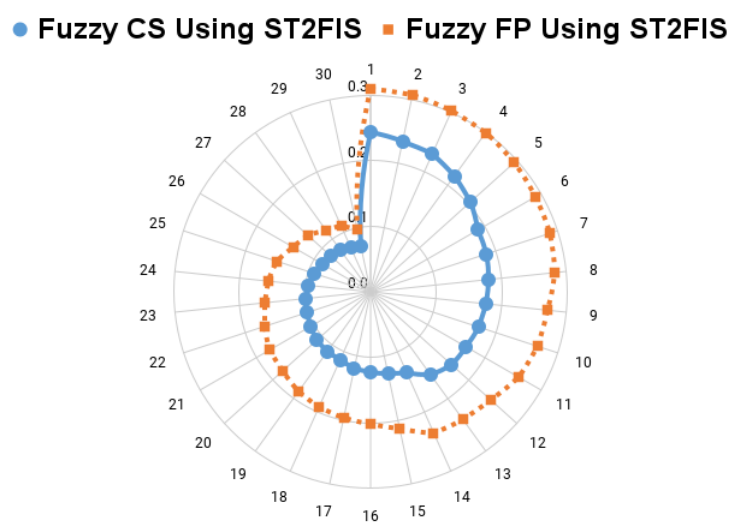
Figure 18. MSE error for TTCFNLC process subject to random noise in fuzzy controller using fuzzy CS and FP algorithms for 30 simulations.